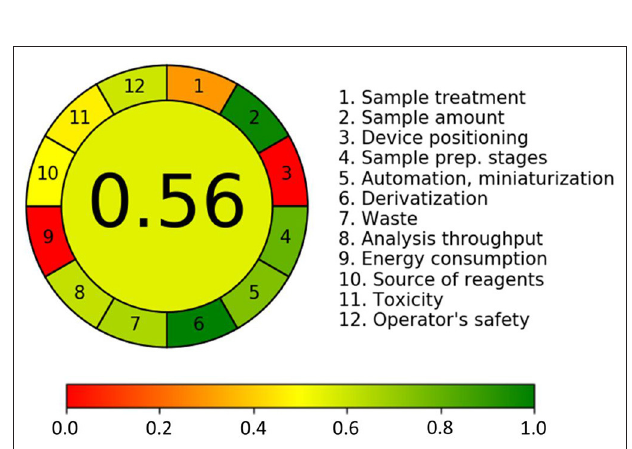
FIGURE 7 | Greenness of the developed method was assessed with Analytical GREEnness metric approach (AGREE); annotated result of a generic assessment (above) and the corresponding color scale for reference